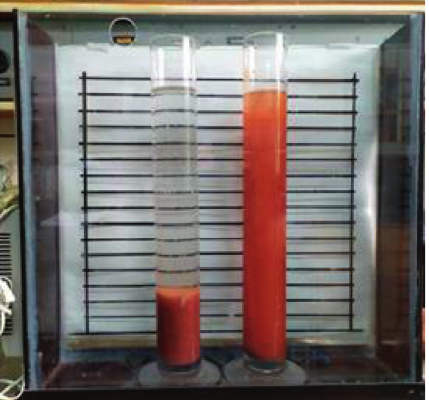
Figure 2: Results of the experiment on removing hydrogen sulfide from sewage water and residual sedimentation using a complex coagulant (left test tube) and without the use of a complex co- agulant (right test